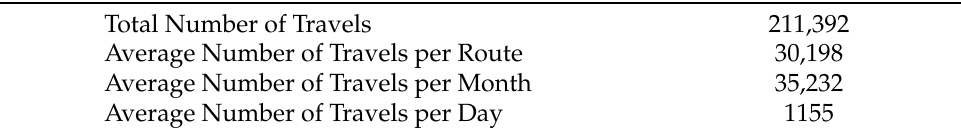
Table 3. Summary for PeMS Data